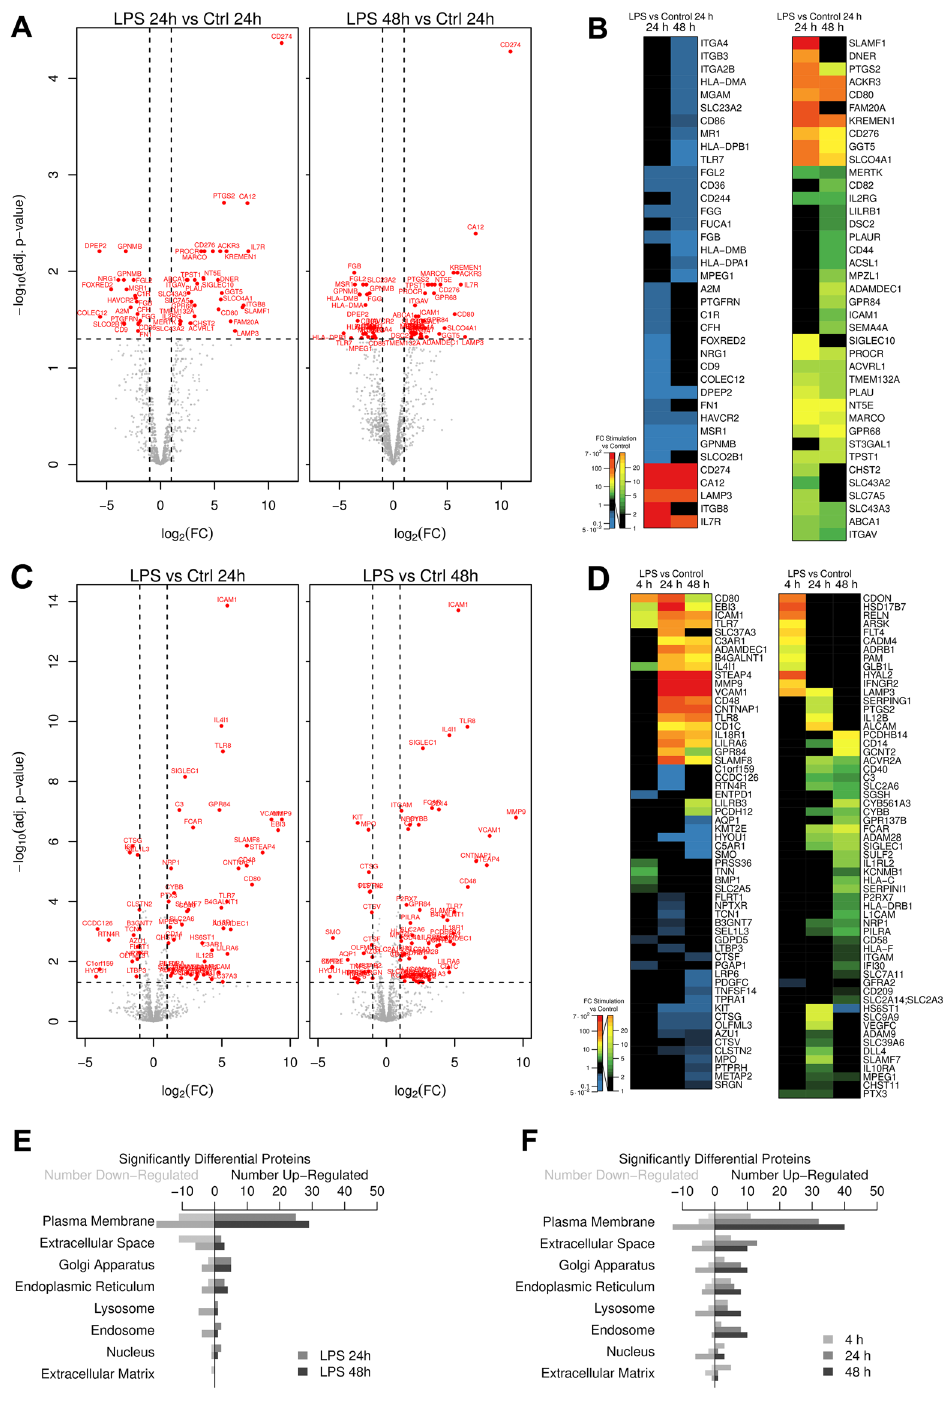
Figure 3. LPS regulated glycoproteins in CD14 + monocytes and THP-1 cells. ( A,B ) Volcano plot ( A ) and heat map ( B ) of differentially expressed glycoproteins in CD14 + monocytes. ( C,D ) Volcano plot ( C ) and heat map ( D ) of differentially expressed glycoproteins in THP-1 cells. ( A,C ) Volcano plots show the t-test p-value plotted against the glycoprotein expression fold change of all identified glycoproteins in CD14 + monocytes and THP-1 cells at 24 h (left) and 48 h (right) of LPS treatment. Data points in lower center area of the plots (grey) display unchanged or glycoproteins with no significant fold change, whereas data points in the upper left and upper right quadrants indicate glycoproteins (red) with significant negative (left) and positive (right) changes in protein abundances, respectively. For illustration gene names are given. ( B,D ) Black boxes in heat maps indicate no fold change at the given time point. Green, yellow, red indicate upregulation and blue indicates down regulation according to the legend. For illustration gene names are given. ( E,F ) Numbers of significantly changed glycoproteins after LPS treatment in selected cellular components at different time points in CD14 + monocytes ( E ) and THP-1 cells ( F ); 4 h = light grey bars, 24 h = dark grey bars, and 48 h = black